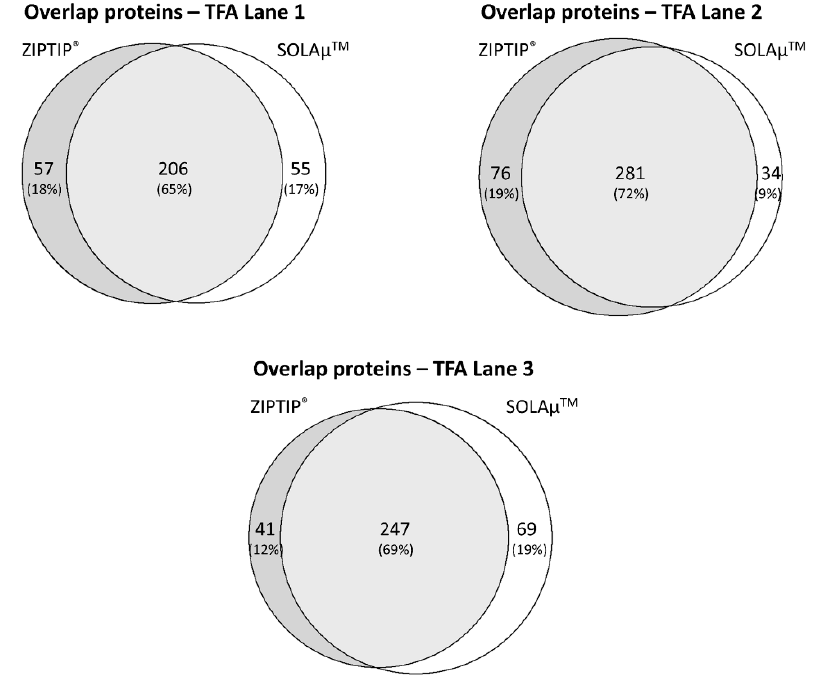
Figure 5. Venn diagram showing the overlap (percentage distribution) of identified proteins in the TFA fraction between six technical replicates. Three technical replicates were either purified by ZIPTIP ® pipette tips or SOLA µ TM microtiter plates. On average 69 ± 4% of all identified proteins were detected with both SPE-based purification methods.